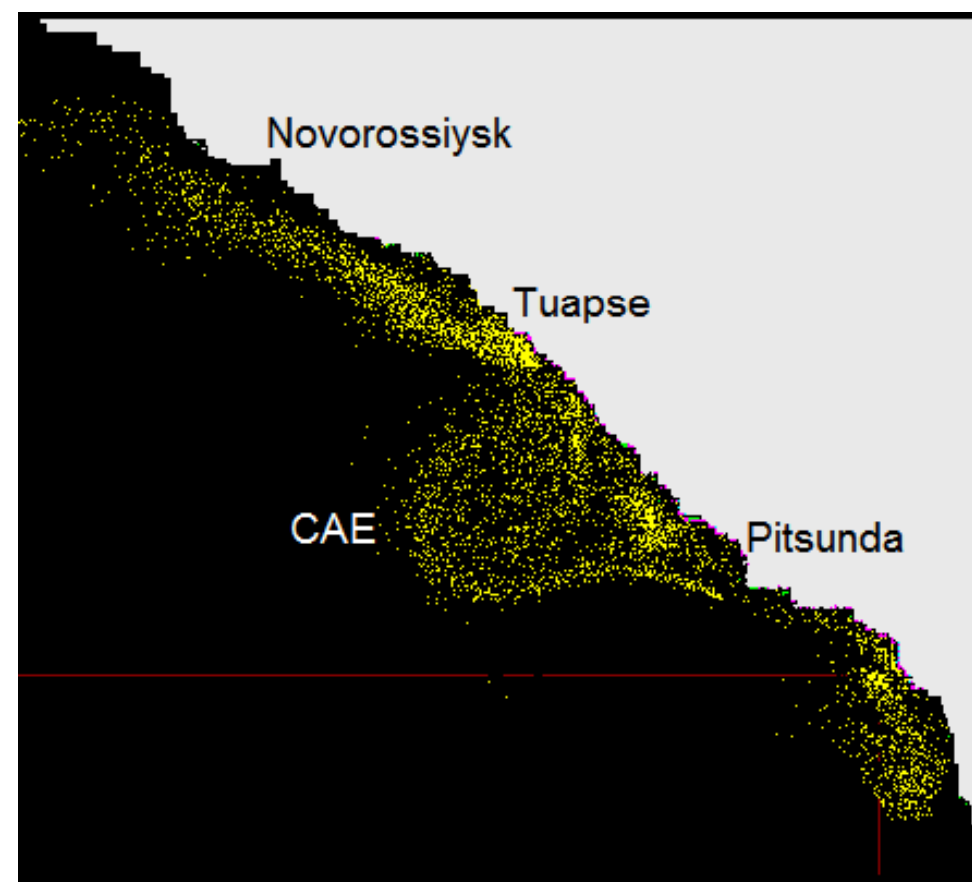
Figure 2. An example of online graphical output from the Lagrangian particle model illustrating particles captured by the Caucasian anticyclonic eddy (CAE). Yellow color indicates particles traveling in the open sea while magenta color denotes those stuck to the shoreline.